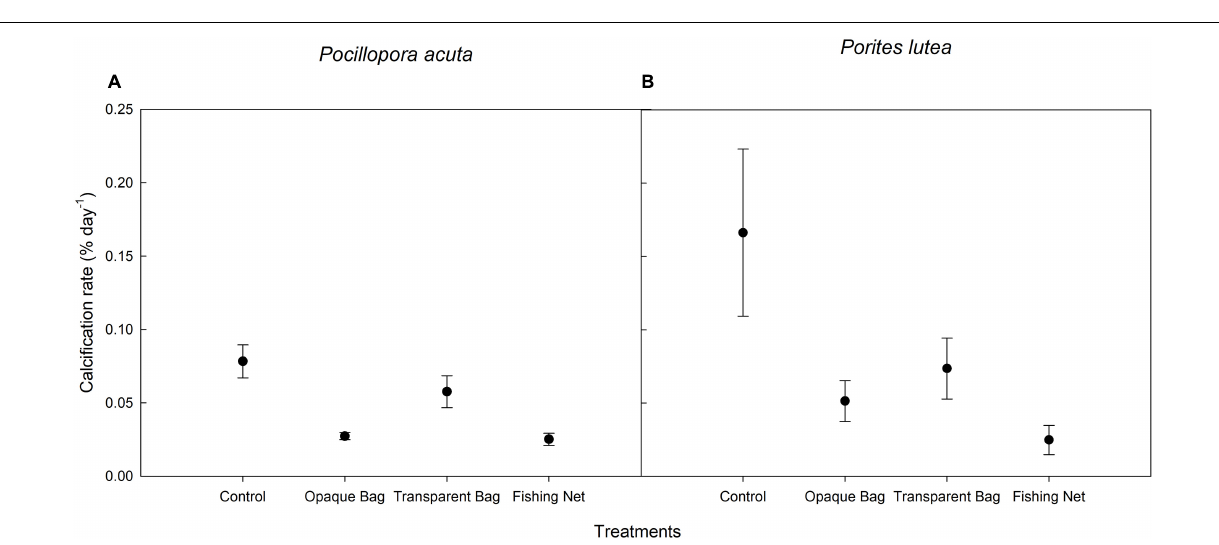
FIGURE 7 | Calcification rate of P. acuta (A) and P. lutea (B) in control, opaque bag, transparent bag, and fishing net treatments. Data are presented as Mean ± SE ( n =